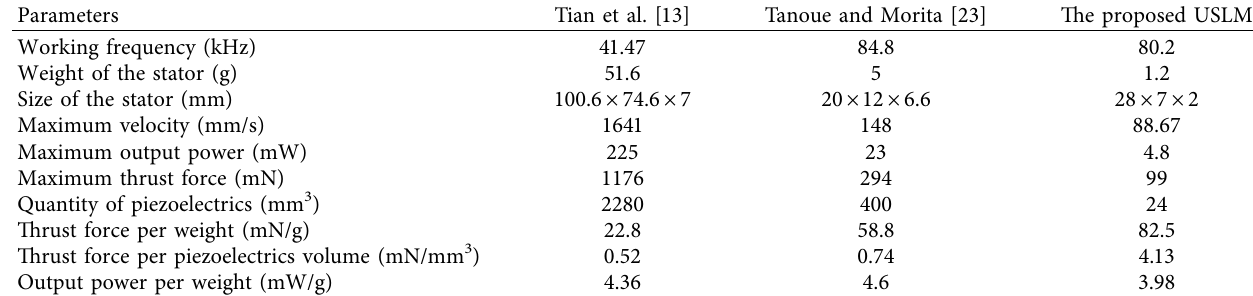
Figure 18: Variation of load characteristics with load force. Table 2: Comparison between the proposed LUSM and 2 previous